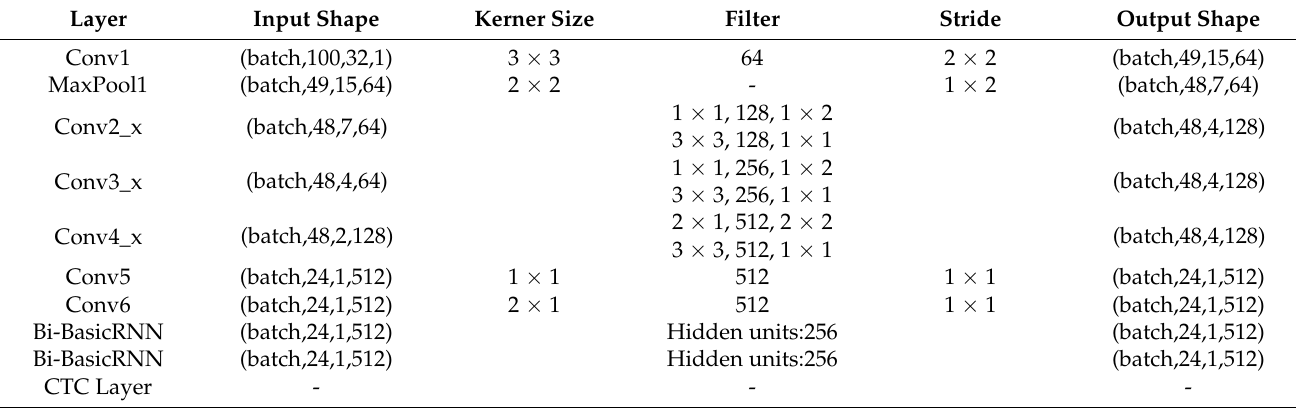
Table 2. Parameters of the proposed model. An input instrument image of 100 × 32 will generate a feature sequence with the dimensions 1 × 24 × 512 after the feature extractor. The outputs from the sequence modeling part have the same dimensions as the